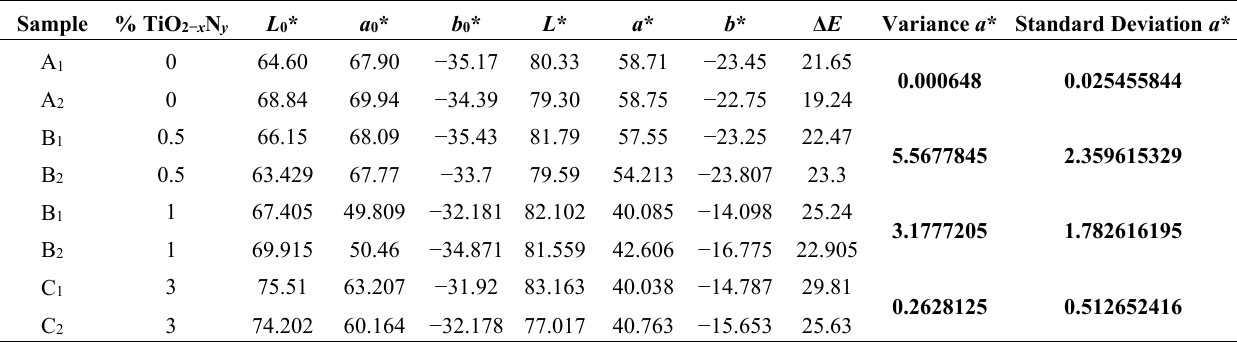
Table 2. Standard deviation of samples with TiO 2 − x N y in visible